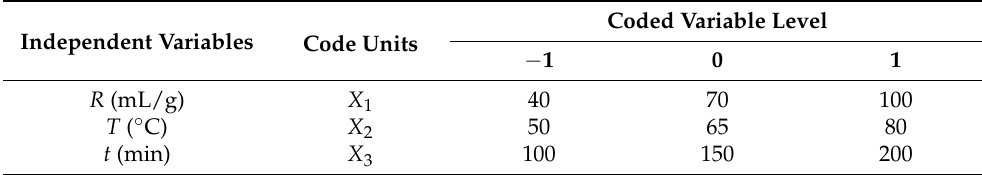
Table 1. Independent variables and their related actual and coded levels utilized to optimize the extraction of TPC.